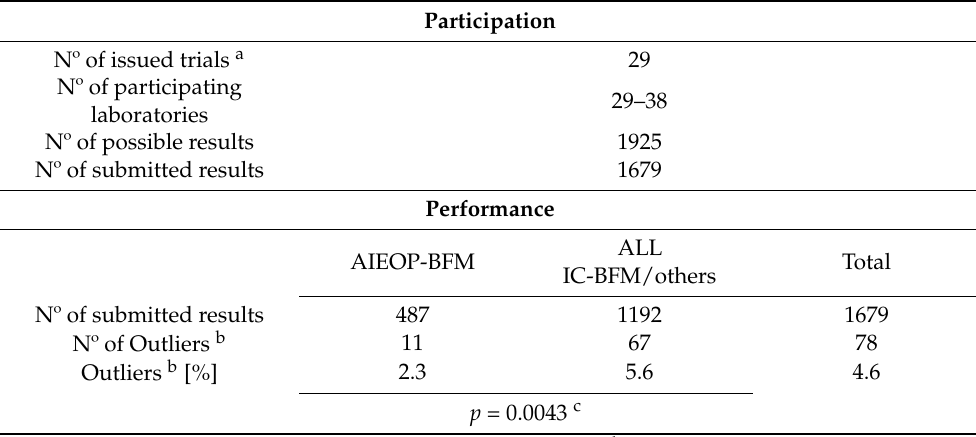
Table 3. Table summarizing participation and performance of AIEOP-BFM and ALL IC-BFM lab- oratories in UK NEQAS “Minimal residual disease for ALL by Flow cytometry” ring trials. Data evaluation was completed with each single ring trial by the I-BFM FLOW coordinating center in Vi- enna. In case of outliers or missing results, the local/individual center was contacted, and corrective measures were discussed. Note that the № of possible results is higher than the number of submitted results, because not all laboratories submitted all